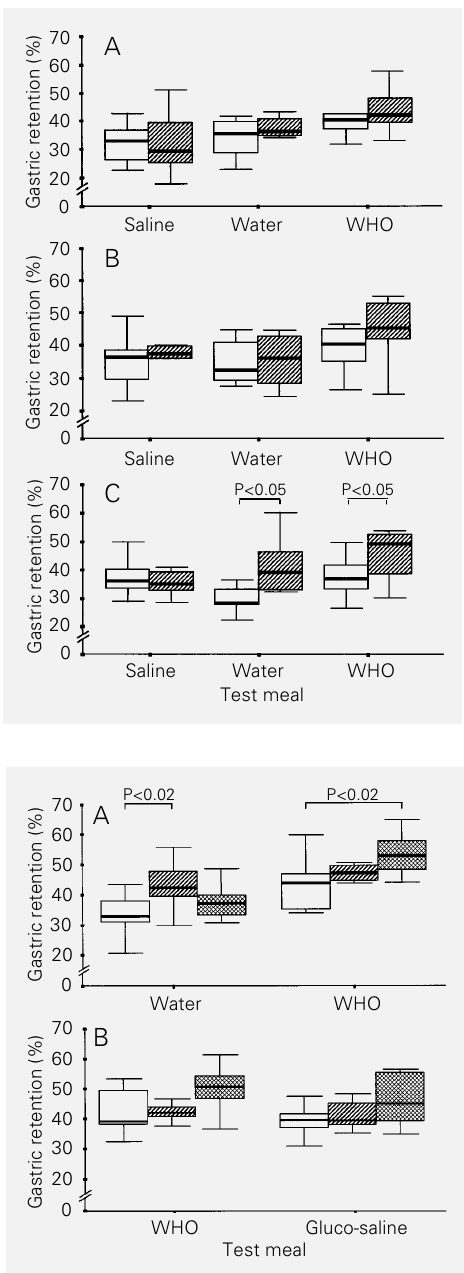
Figure 2 - Gastric retention val- ues for different test meals 10 min after orogastric administra- tion to rats (2 ml/100 g) in the 72-h water deprivation study. The results are presented as box plots for 10 rats in each group. For an explanation of the box plots, see the legend to Figure 1. A , No water deprivation (open boxes), total deprivation (striped boxes) and total water depriva- tion but with access to water for 60 min (grid boxes). B , No water deprivation (open boxes), total deprivation (striped boxes) and total water deprivation but with access to water for 120 min (grid boxes) (P<0.02, Kruskal-Wallis